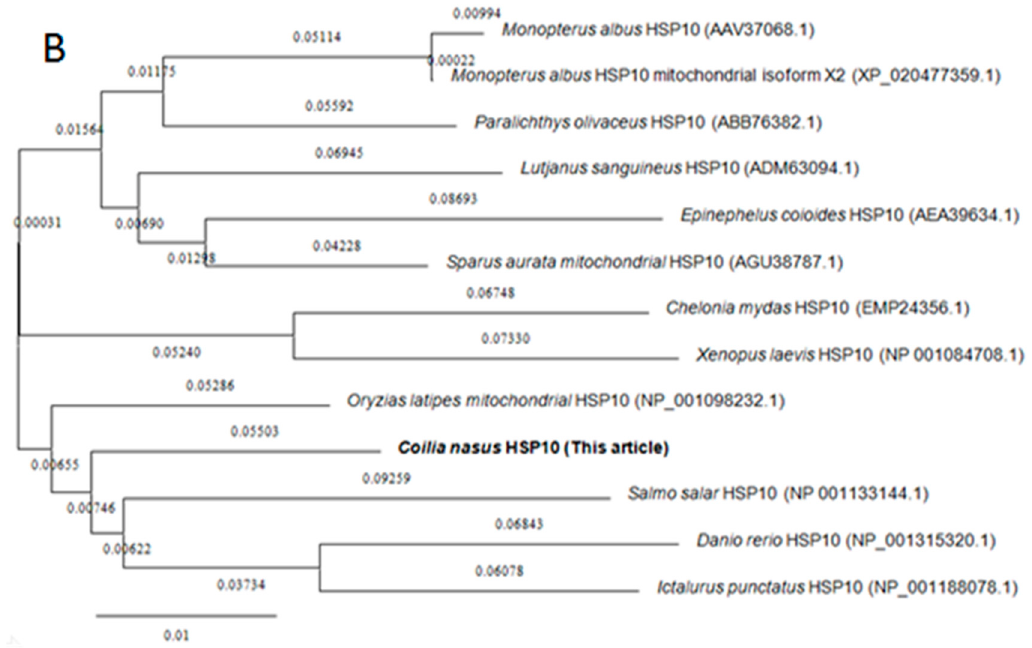
Figure 2. Phylogenetic trees of HSP60 and HSP10 family members. Phylogenetic tree constructed by the MEGA 4.0 program by the neighbor-joining distance method. ( A ) is for HSP60s and ( B ) for HSP10s. The statistical robustness of the tree was estimated by bootstrapping with 1000 replicates. Bootstrap values were indicated by genetic distance.